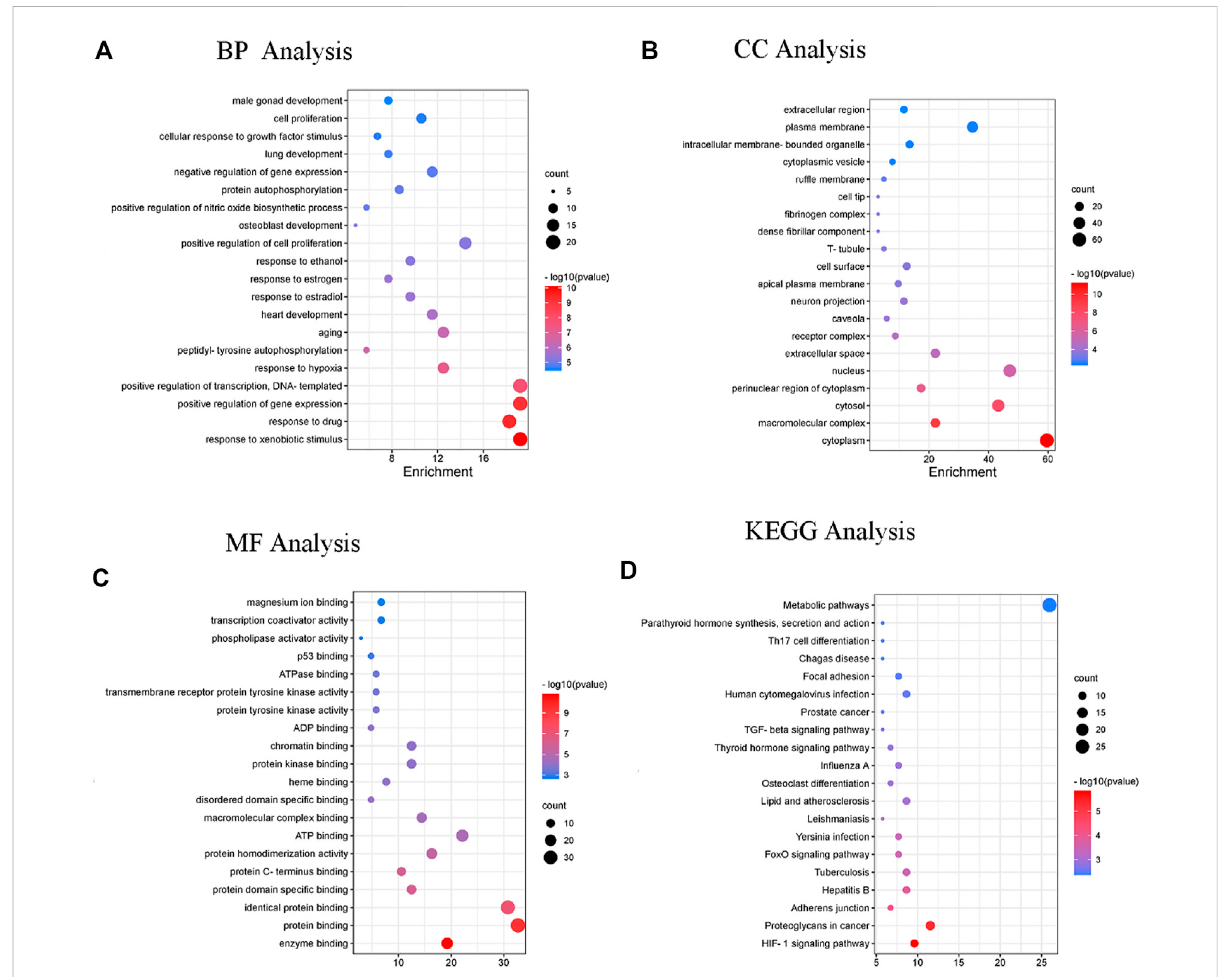
FIGURE 9 The enrichmentanalysis of GO andKEGG pathway ofDPfor thetreatment ofDFU. Enriched GO termsarefor (A) BPanalysis (B) CCanalysis (C) MF analysis; and (D) KEGG pathway analysis.